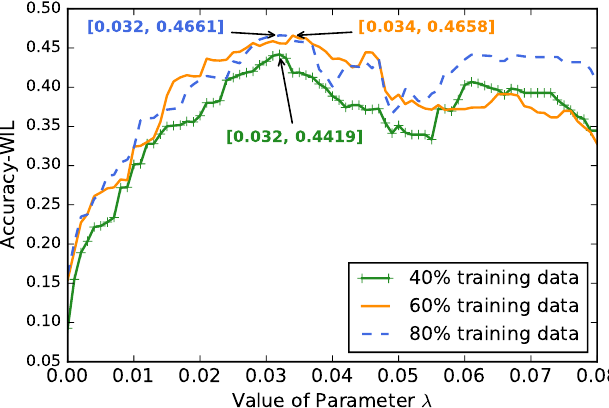
Figure 9. Average Accuracy-WIL vs. value of parameter λ ranging from 0 to 0.08 with a step size of 0.001. The curves reach their peaks when 0.03 ≤ λ ≤